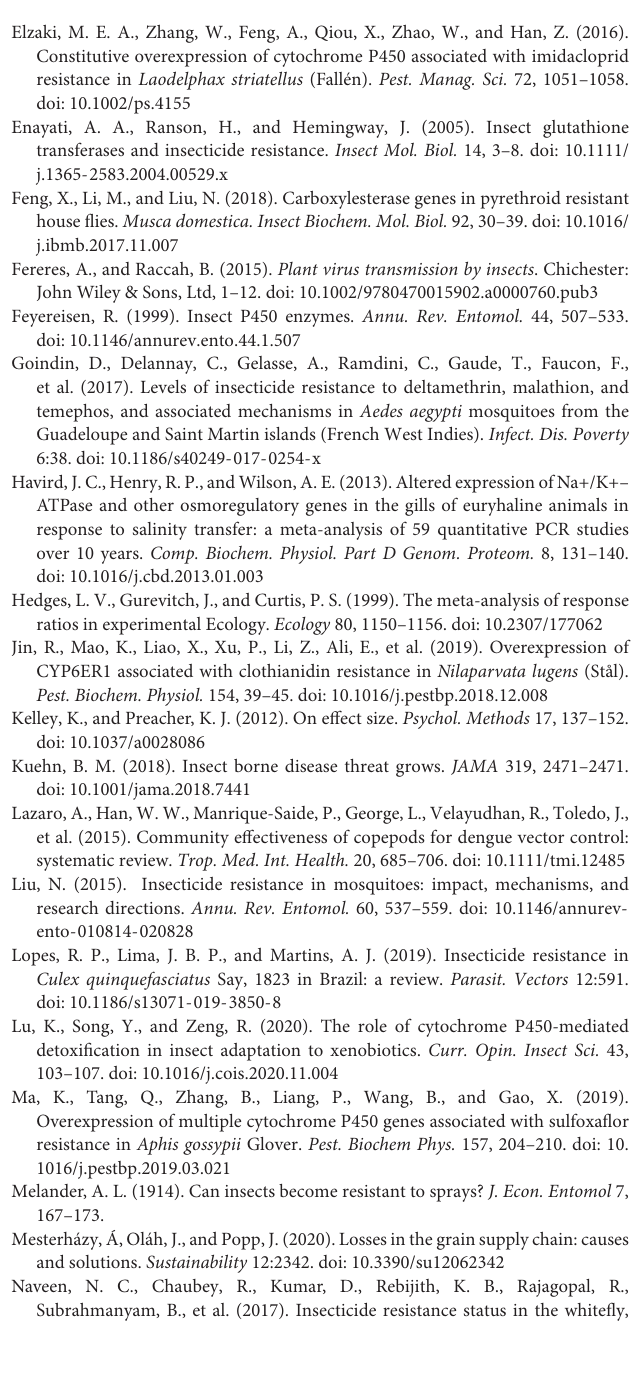
Supplementary Table 1 | List of specific summary and data for each paper in meta-analyses. Supplementary Table 2 | Effect sizes for subgroups. Supplementary Table 3 | Sensitivity analysis for the unweighted meta-analysis. Supplementary Table 4 | Sensitivity analysis for the weighted meta-analysis. Supplementary Data 5 | R code for